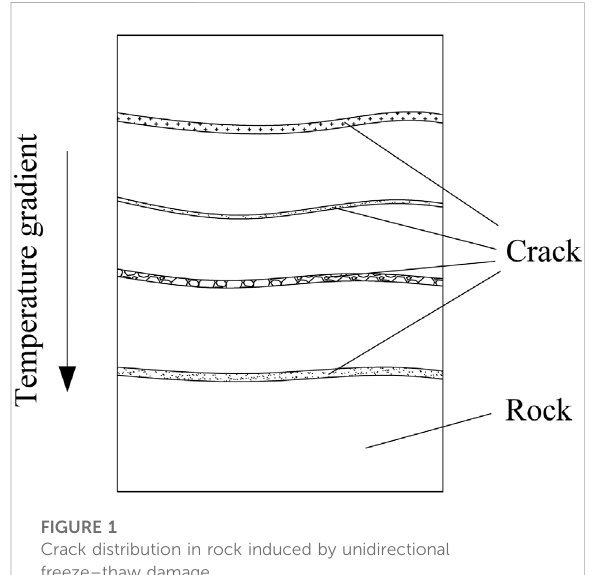
FIGURE 2 Transverse isotropy of rock induced by unidirectional freeze – thaw